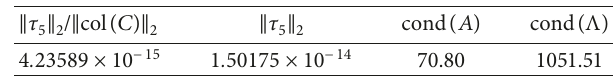
Table 3: L norm of the errors obtained by predictor-corrector 2 algorithm for Example